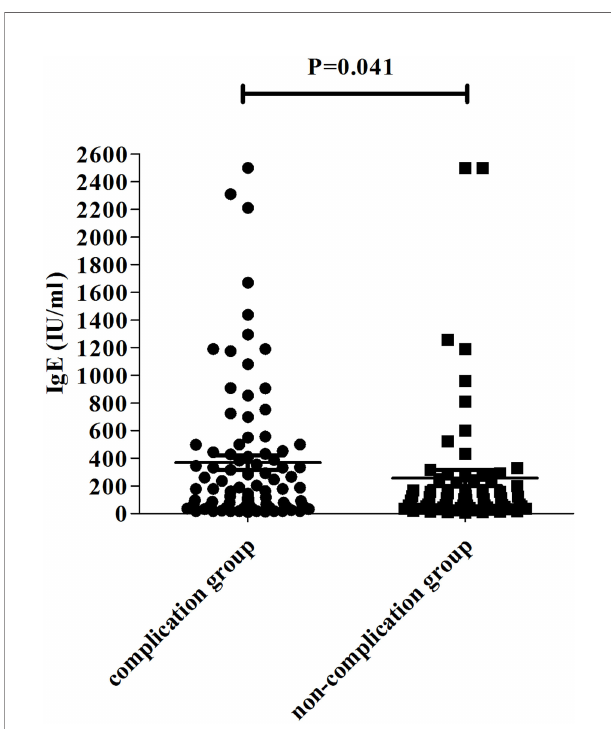
FIGURE 2 | The IgE level in the complication group and the non- complication group.